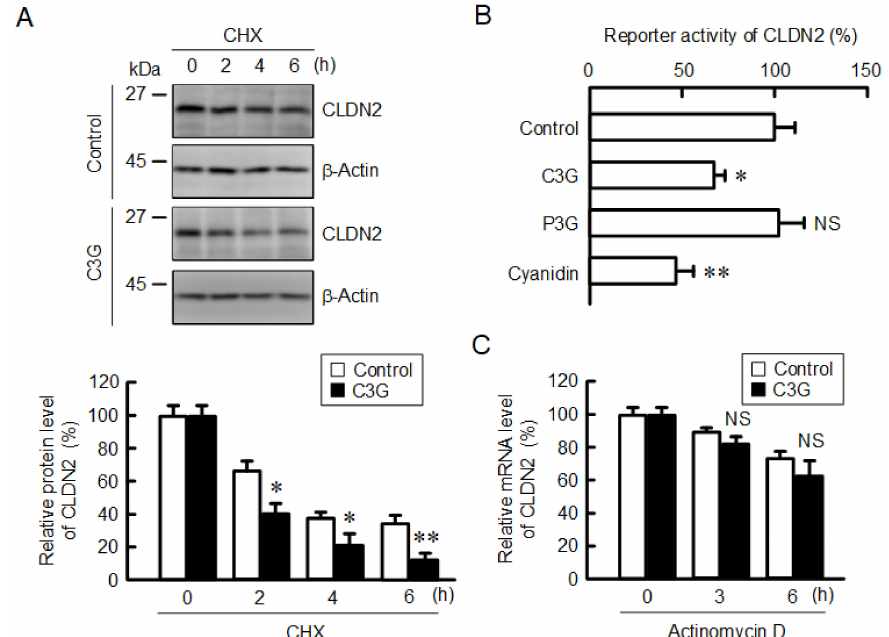
Figure 5. Decrease in the protein stability and reporter activity of CLDN2 by C3G. ( A ) Cells were incubated with 10 µ M CHX in the absence and presence of 50 µ M C3G for 0, 2, 4, and 6 h. Cell lysates were immunoblotted with anti-CLDN2 and anti- β -actin antibodies. The protein levels of CLDN2 are represented as a percentage relative to control. ( B ) Cells were incubated in the absence (control) and presence of 50 µ M anthocyanins for 6 h, and then the reporter activity was measured by the Dual-Luciferase Reporter Assay System. The reporter activity is represented as a percentage relative to control. ( C ) Cells were incubated with 1 µ g/mL actinomycin D in the absence and presence of 50 µ M C3G for 0, 3, and 6 h. The mRNA level of CLDN2 was measured by quantitative real-time PCR and represented as a percentage relative to 0 h. Int. J. Mol. Sci. 2021 , 22 , x n = 3–5. ** p < 0.01, * p < 0.05 and NS p > 0.05 compared with control or 0 h.